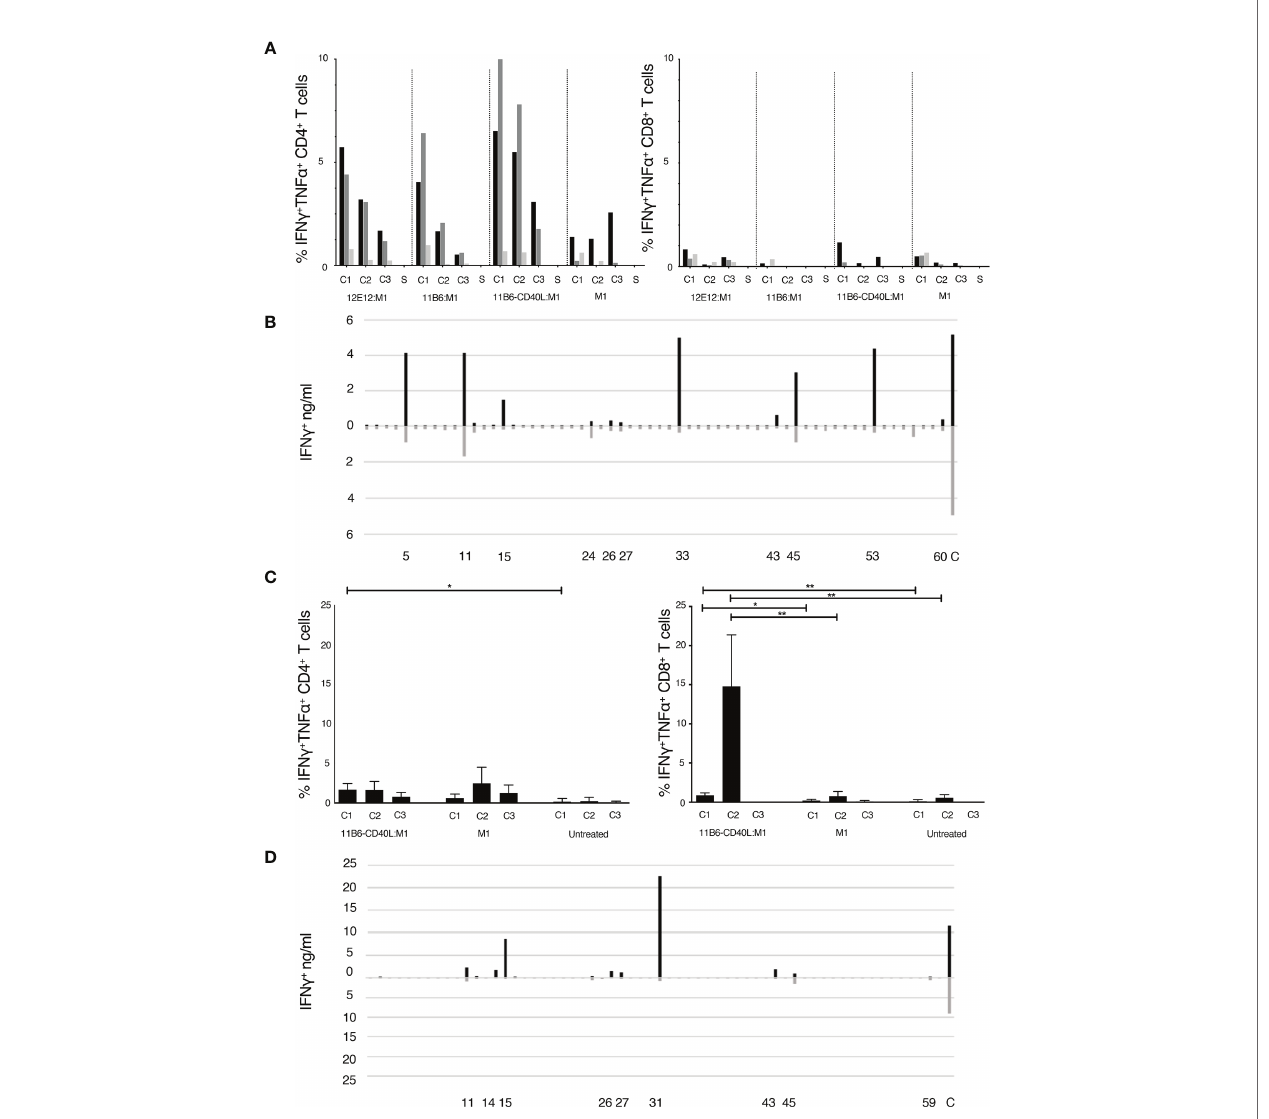
FIGURE 1 | (A, C) Expansion of epitope-reactive T cells by M1 protein formulations. Analysis of Flu M1-speci fi c T cell responses in a day 10 ND1004 (A) and ND1005 (C) PBMC culture stimulated with CD40-targeted Flu M1 protein. The left panel shows the % of IFN g + and/or TNF a + antigen-speci fi c CD4 + T cells as determined by ICS analysis. Baseline values for solvent (S, no peptide) controls were subtracted. In (A) cultures contained a dose range (1 nM, black bars; 0.1 nM grey bars; 0.01 nM light grey bars) of CD40-targeting antibodies conjugated to cohesin Flu M1 or Flu M1 alone (M1), while in (C) only one dose (1 nM) was tested. The right panel shows analogous data for % of IFN g + and/or TNF a + CD8 + T cells. In (A) baseline S values for the CD4 + were 0.43 ± 0.14%, and for the CD8 + were 0.8 ± 0.4%. Compared to a starting input of PBMCs, the end stage 10 day cultures increased in total numbers as follows for, respectively, the 1, 0.1, and 0.01 nM conditions: anti-CD40 12E12:M1 5.6, 3.6,1.6-fold; anti-CD40 11B6:M1 12.5, 2.5, 0.9-fold; anti-CD40 11B6-CD40L:M1 7, 2.7 1-fold; and M1 1.5, 0.9, 0.8-fold. In (C) the data show results from 4 independent experiments with ND1005. Values for solvent without peptide stimulation (S) were subtracted from each